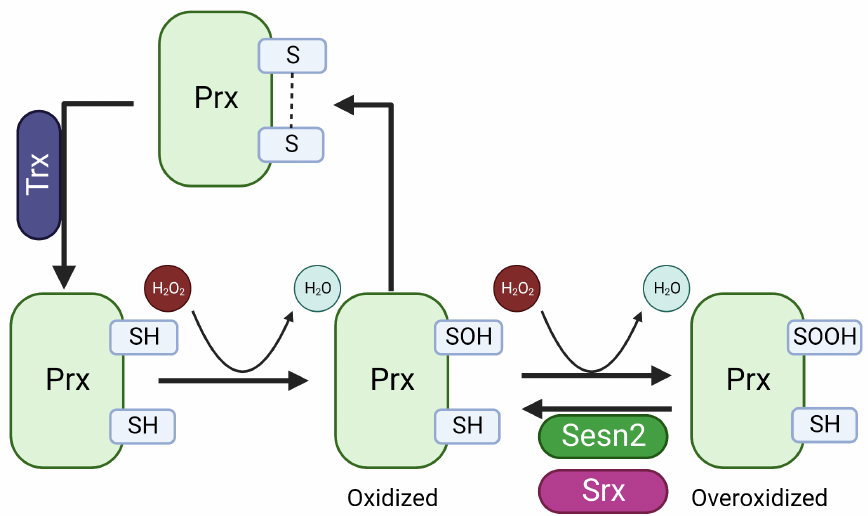
Figure 6. The generation of overoxidized peroxiredoxin by hydrogen peroxide and the reduction by SESN2 and sulfiredoxin. Oxidized Prx is reduced by Trx during low oxidative stress. High oxidative stress over-oxidizes Prx which is regenerated either by SESN2 or Srx. SESN2 is known to increase Srx expression through KEAP1/NRF2 pathway. Prx: Peroxiredoxin; Trx: Thioredoxin; Srx: